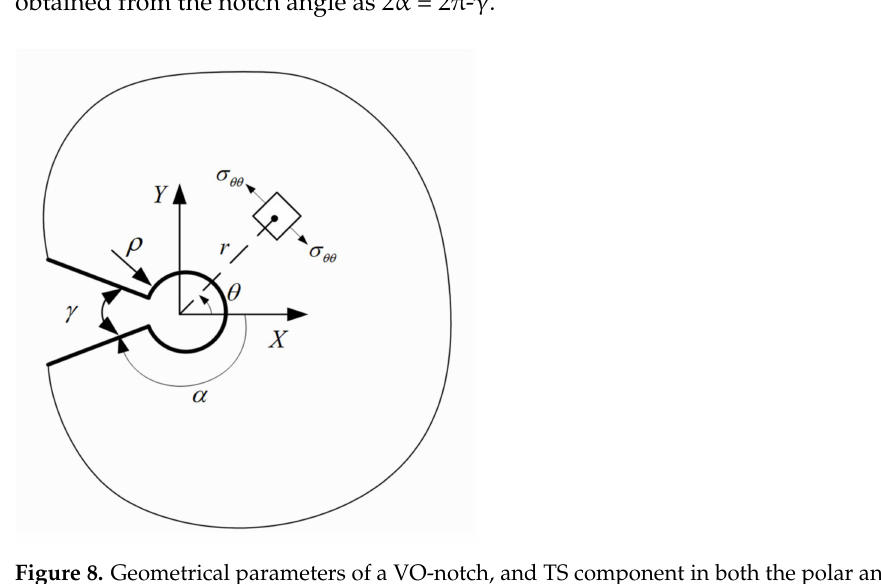
Figure 8. Geometrical parameters of a VO-notch, and TS component in both the polar and Cartesian coordinates